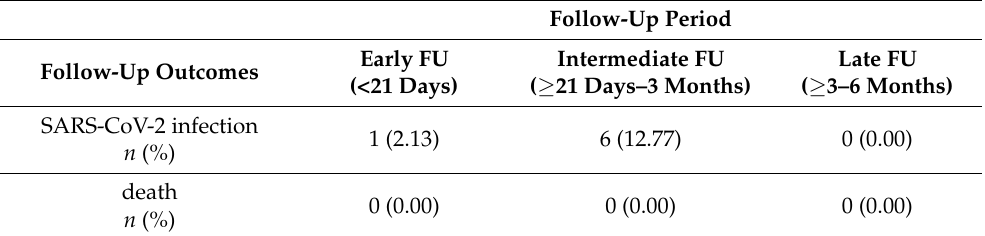
Table 4. Results of the 6-month follow-up period: diagnosed SARS-CoV-2 infection (RT-PCR- confirmed) in the study group (primary ChAd/ChAd recipients), following a (BNT) booster adminis- tration ( n =